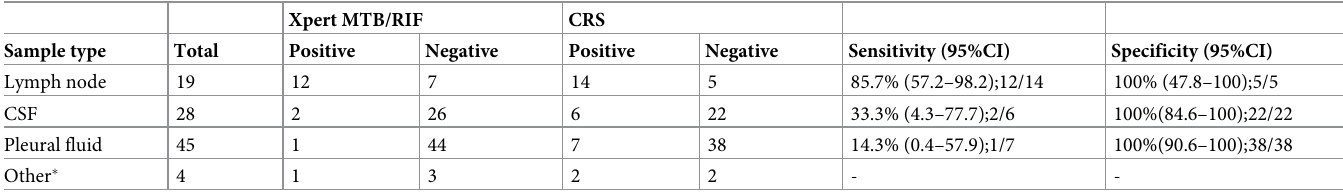
Table 3. Performance of Xpert MTB/RIF test among different non respiratory